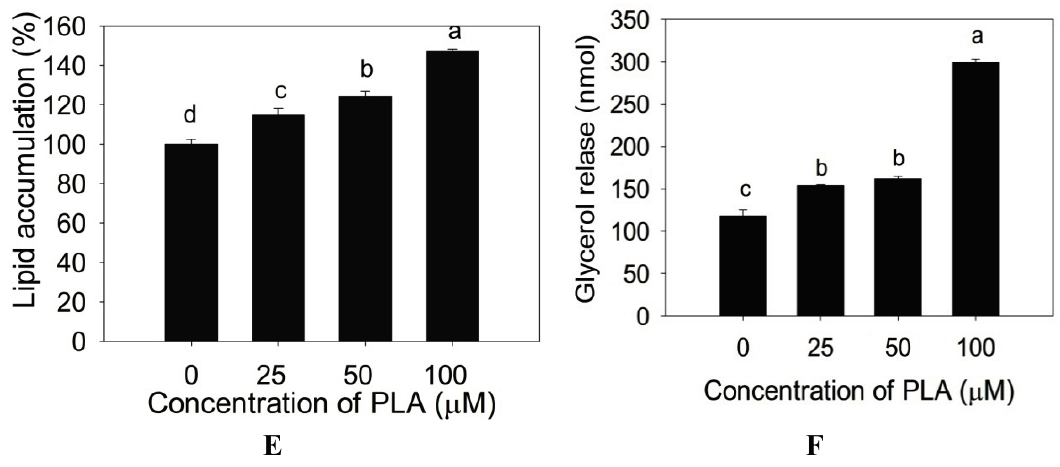
E F Figure 3. Oil Red O staining of lipid accumulation and glycerol release in adipocyte on the 10th day. ( A ) Control; ( B ) 25 µM; ( C ) 50 µM; ( D ) 100 µM; ( E ) % of lipid extracted